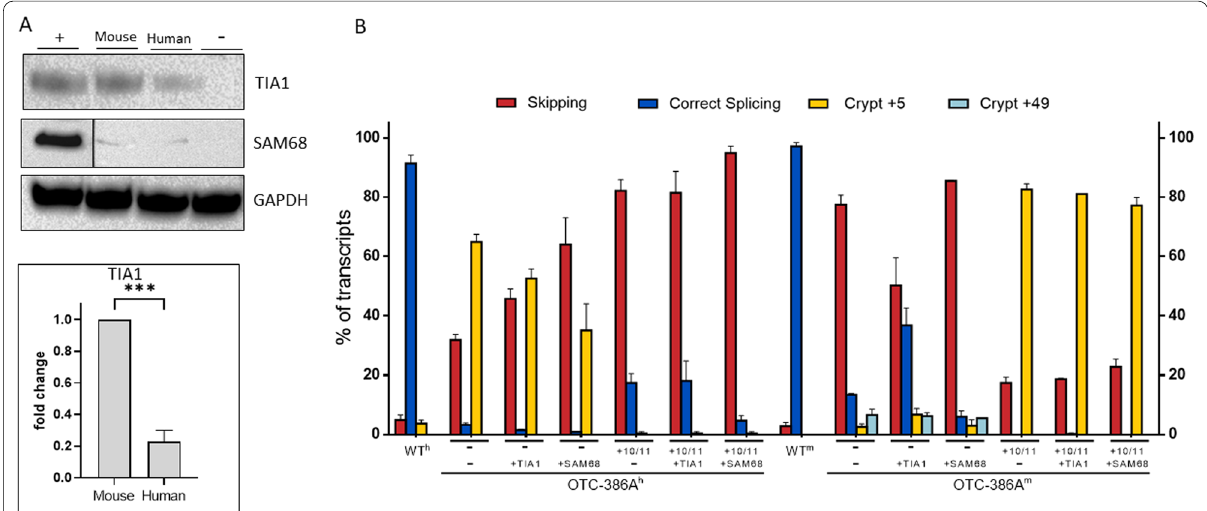
Fig. 3 TIA1 preferentially binds nucleotide variations at 10-11 positions in mouse. A Western blot analysis of pulldown assays. Results are + presented as mean standard deviation (SD) of three independent experiments and a representative blot is shown ( NE nuclear extract input; ± C- naked beads). Histograms report fold changes over the wild-type. *p < 0.1; **p < 0.01; ***p < 0.001; ****p < 0.0001. B Splicing patterns of OTC h and OTC m minigenes in Hepa1-6/HepG2 cells expressing minigenes variants alone or in combination with TIA1 or Sam68-expressing plasmids. Bar plots report the relative percentage of each transcript, which is expressed as mean standard deviation (SD) from three independent experiments. The ± transcript type is indicated on the